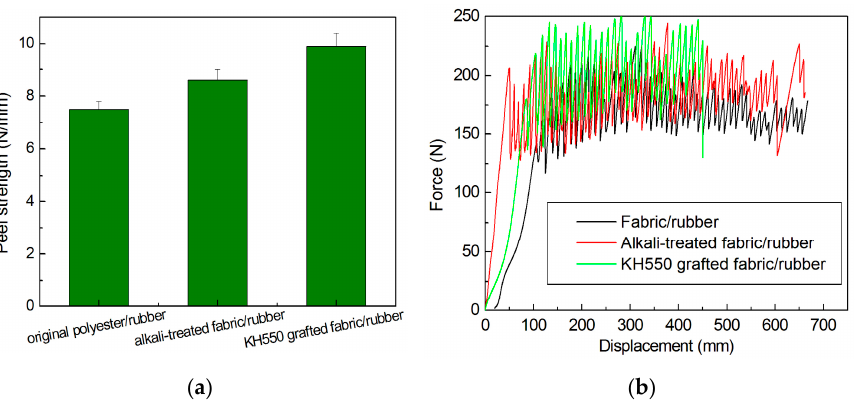
Figure 9. ( a ) Peel strength; ( b ) peel curves of fabric/rubber under different fabric surface treatments. The macro-photographs of the interfacial fracture surface of the fabric composites The fabric surface was bright and the rubber was black (Figure 10a), which indicated that the interfacial adhesion was low. A wholly dark surface of fabric compared with that of formed, indicating that the interfacial adhesion was larger than that of the original fabric was treated by alkali solution. As shown in Figure 10c, a large amount of rubber adhered to the fabrics and the rubber layer also had a lot of holes (red circles). These only the interfacial failure. Hence, KH550-grafted fabric/rubber composites had the strongest interfaces to resist stripping.